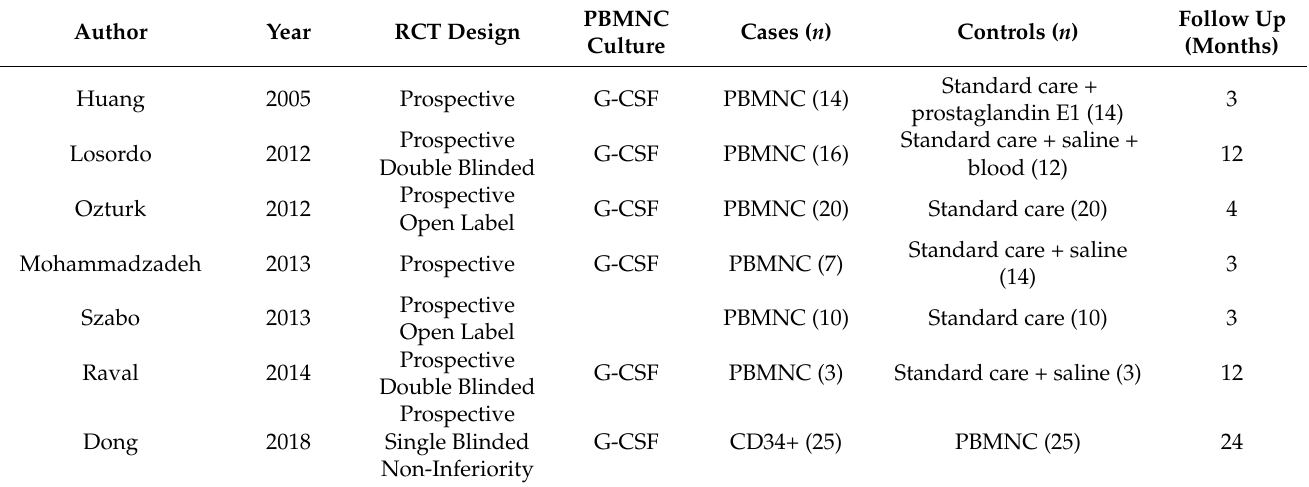
Table 1. Principal characteristics of RCT studies on